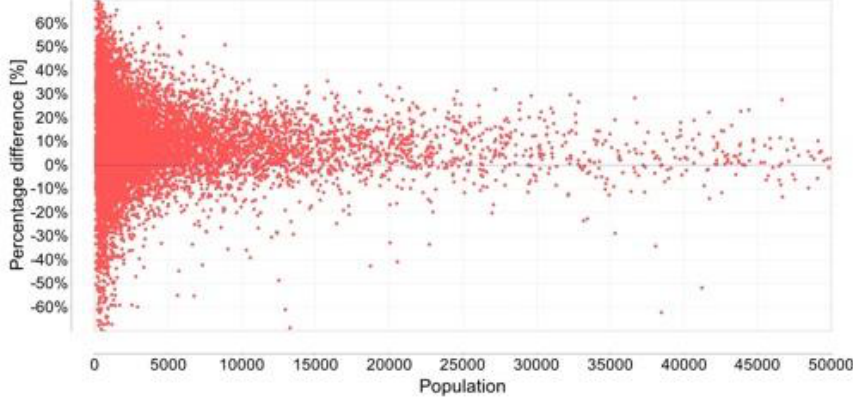
Figure 10. Correlation between Dataset Differences and Population Density (June 2011).